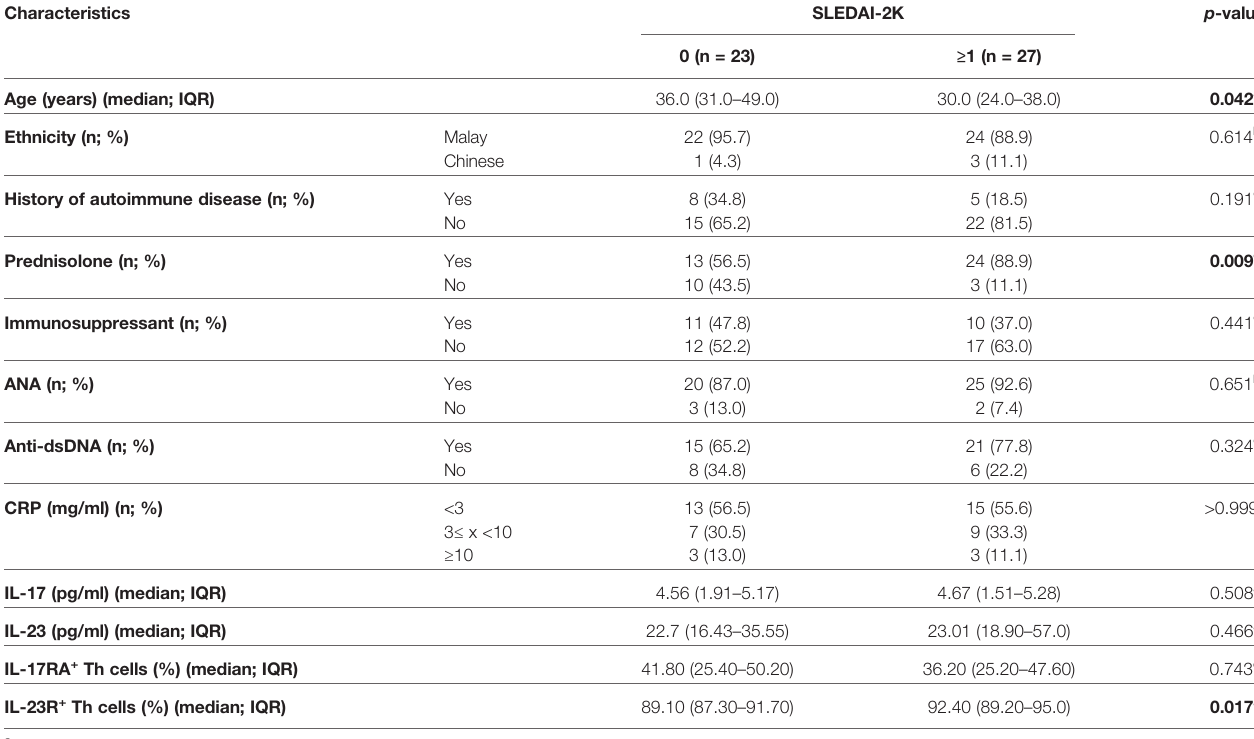
TABLE 2 | Association of the clinico-demographical and immunological characteristics with SLEDAI-2K scores in SLE patients (n = 50).